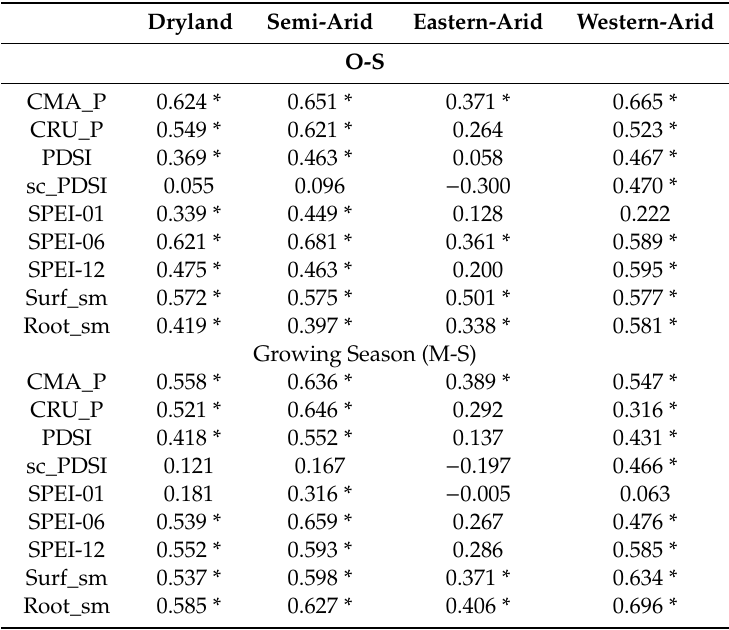
Table 3. Correlation coe ffi cients between M-S NDVI and the nine dryness indicators during M-S and